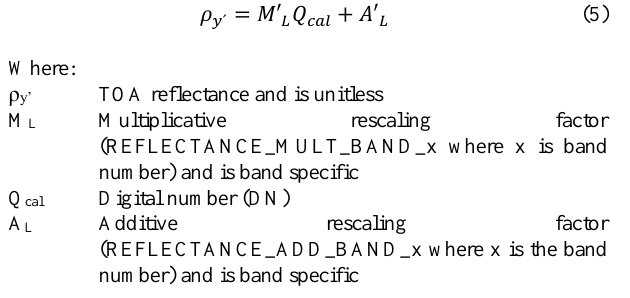
Table 2: Satellite imagery acquired for LST analysis Available satellite imagery for afternoon and night time was for the years 2000, 2005, 2011 and 2017. LST from Landsat 5, Landsat 7 and Landsat 8 were derived using the ‘single channel method’ in ArcMap 10.7 where one band was used (Cristóbal et al ., 2018). ASTER imagery was processed in ENVI 5.1 where all thermal bands were analyzed together using the three-step method to calculate the LST. Landsat 5 TM was converted to Landsat 7 ETM+ equivalent data to compute the top of atmosphere (TOA) (Equation 1). This has been elaborated by Vogelmann et al ., (2001), with Firl & Carter (2011) describing how one can compute to Landsat 5 TM from Landsat 7 ETM+.